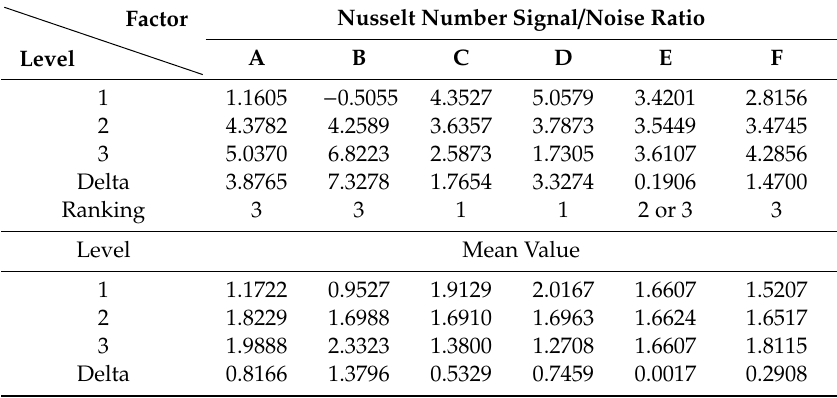
Table 5. The results of the local Nusselt number and signal / noise ratio orthogonal table simulation.